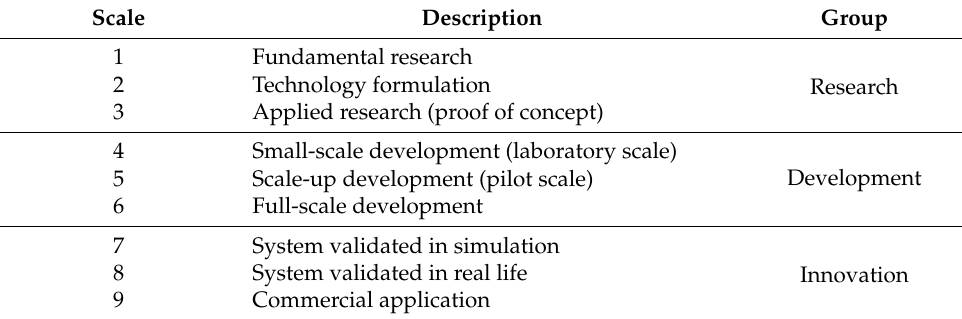
Table 8. Indicator scale for the technology readiness level indicator (TRL I ). Scale